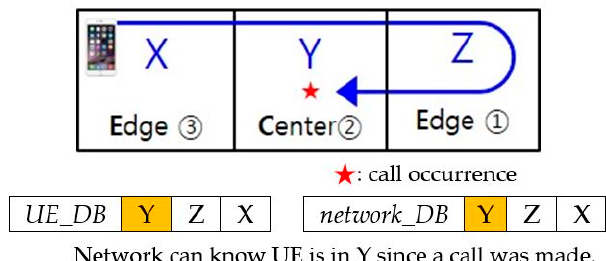
Figure 6. A call occurs in a 3Z system.